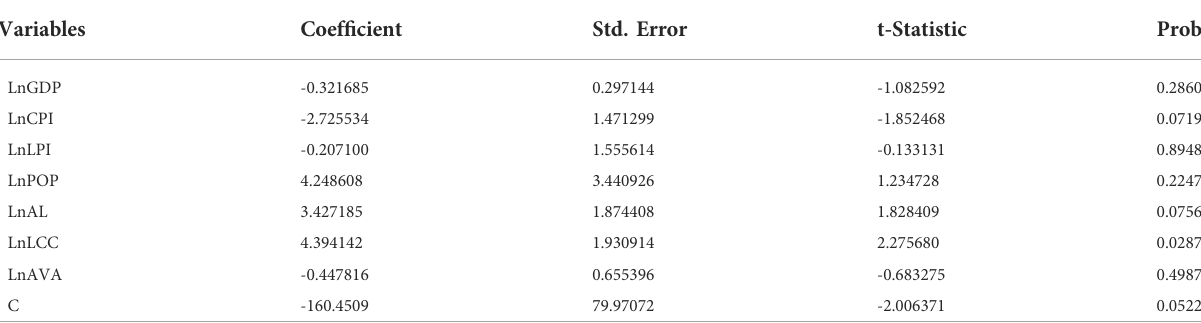
TABLE 8 ARDL long-run and short-run estimations [selected model: (1, 1, 2, 2, 1, 0, 0, 0)]. Long-run